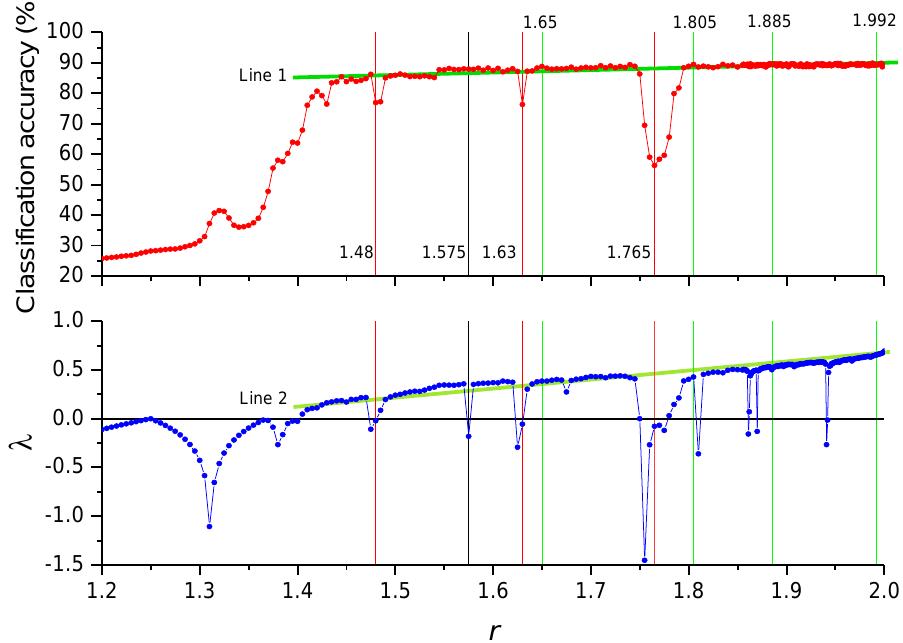
Figure 7. Comparison of classification accuracy (LogNNet-784:100:10) and Lyapunov exponent λ on the parameter r . Vertical green marks with labelled r values correspond to local maxima of classification accuracy values, red marks correspond to local minima. One of the local minima of the Lyapunov exponent values is marked with a black mark. Line 1 is an approximating line for classification accuracy values. Line 2 is an approximating line for λ values.